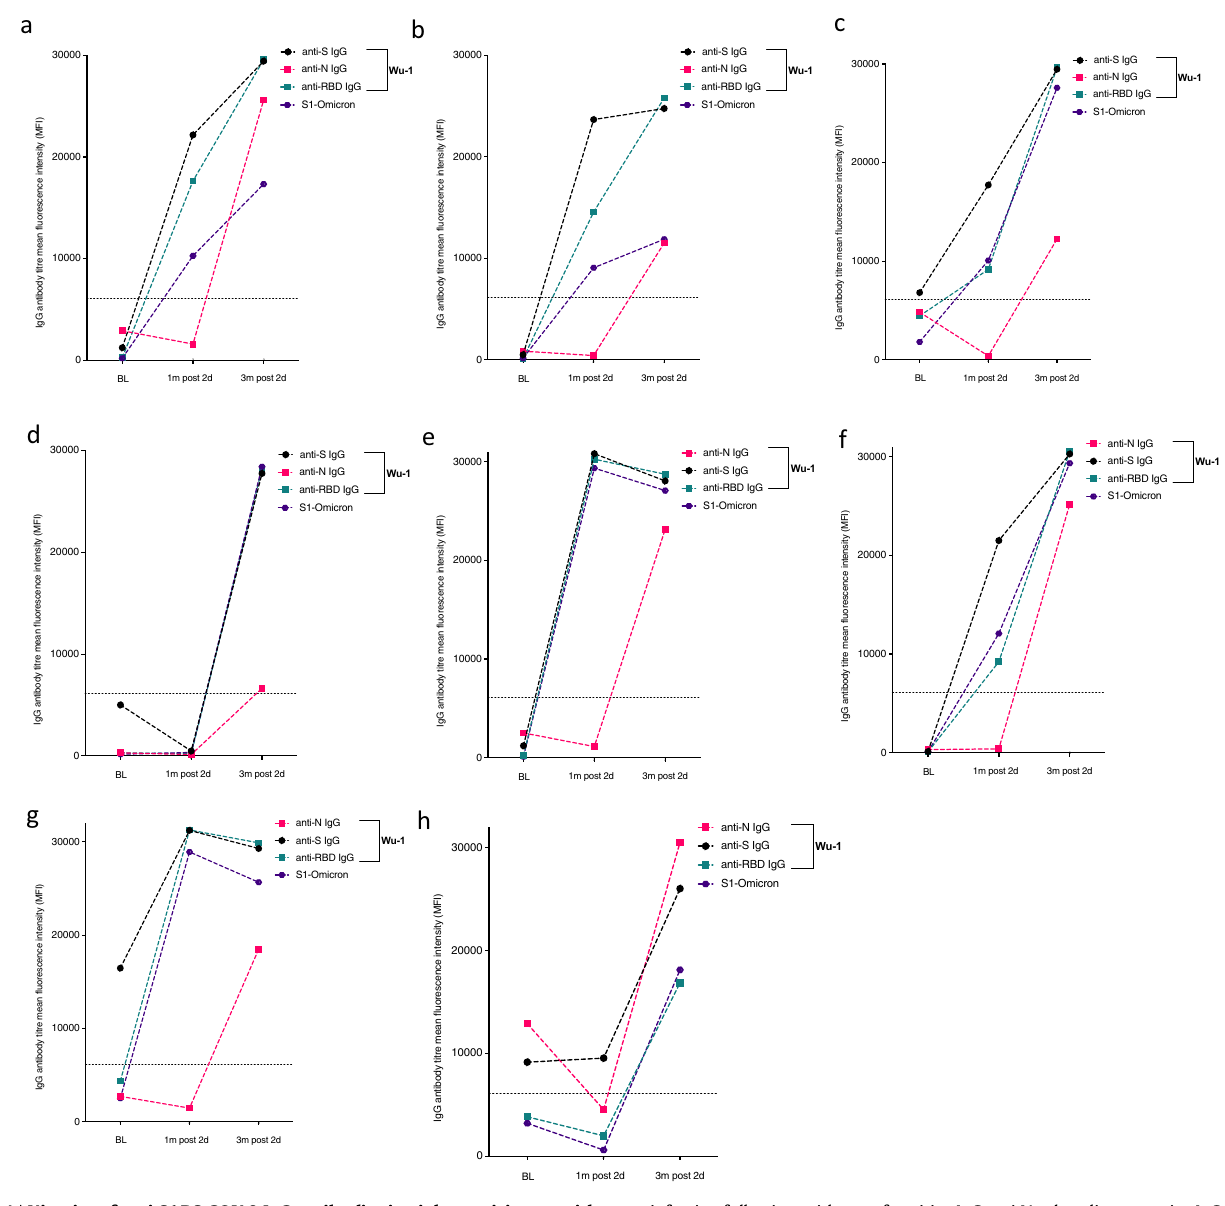
reinfectionfollowingevidenceofpositiveIgGanti-Natbaseline;negativeIgGanti-N at 1month after second dose and positive IgG anti-N 3months post-second dose. Binding antibodies to Wu-1 and Omicron BA.1 are